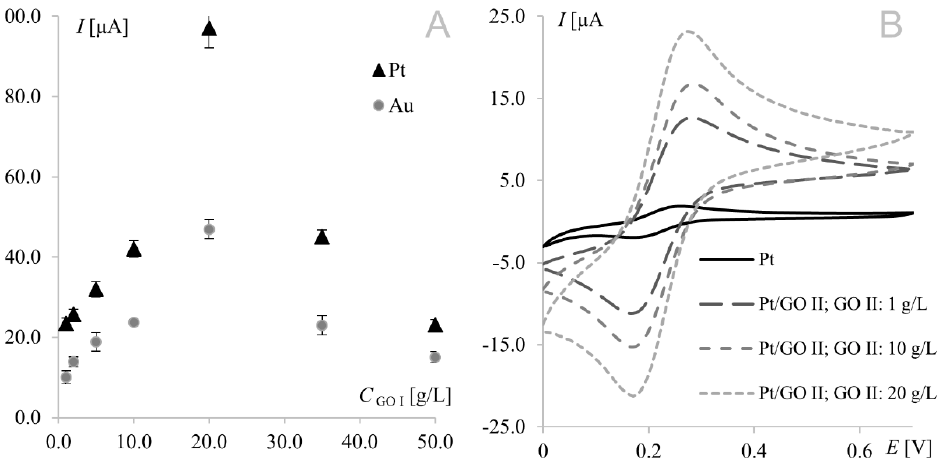
Figure 2. ( A ) Relationship between 1 mM Fe(CN) 64 − anodic peak current recorded at the plati- num/gold electrode modified with graphene oxide I suspensions prepared in dimethylformamide (GO I concentrations from 1 to 50.0 g L − 1 ). ( B ) Voltammograms of 1.0 mM Fe(CN) 63 − / Fe(CN) 64 − rec- orded at the bare platinum electrode and at the electrode modified with graphene oxide II; scan rate, 50 mV s − 1 ; supporting electrolyte, 1 M